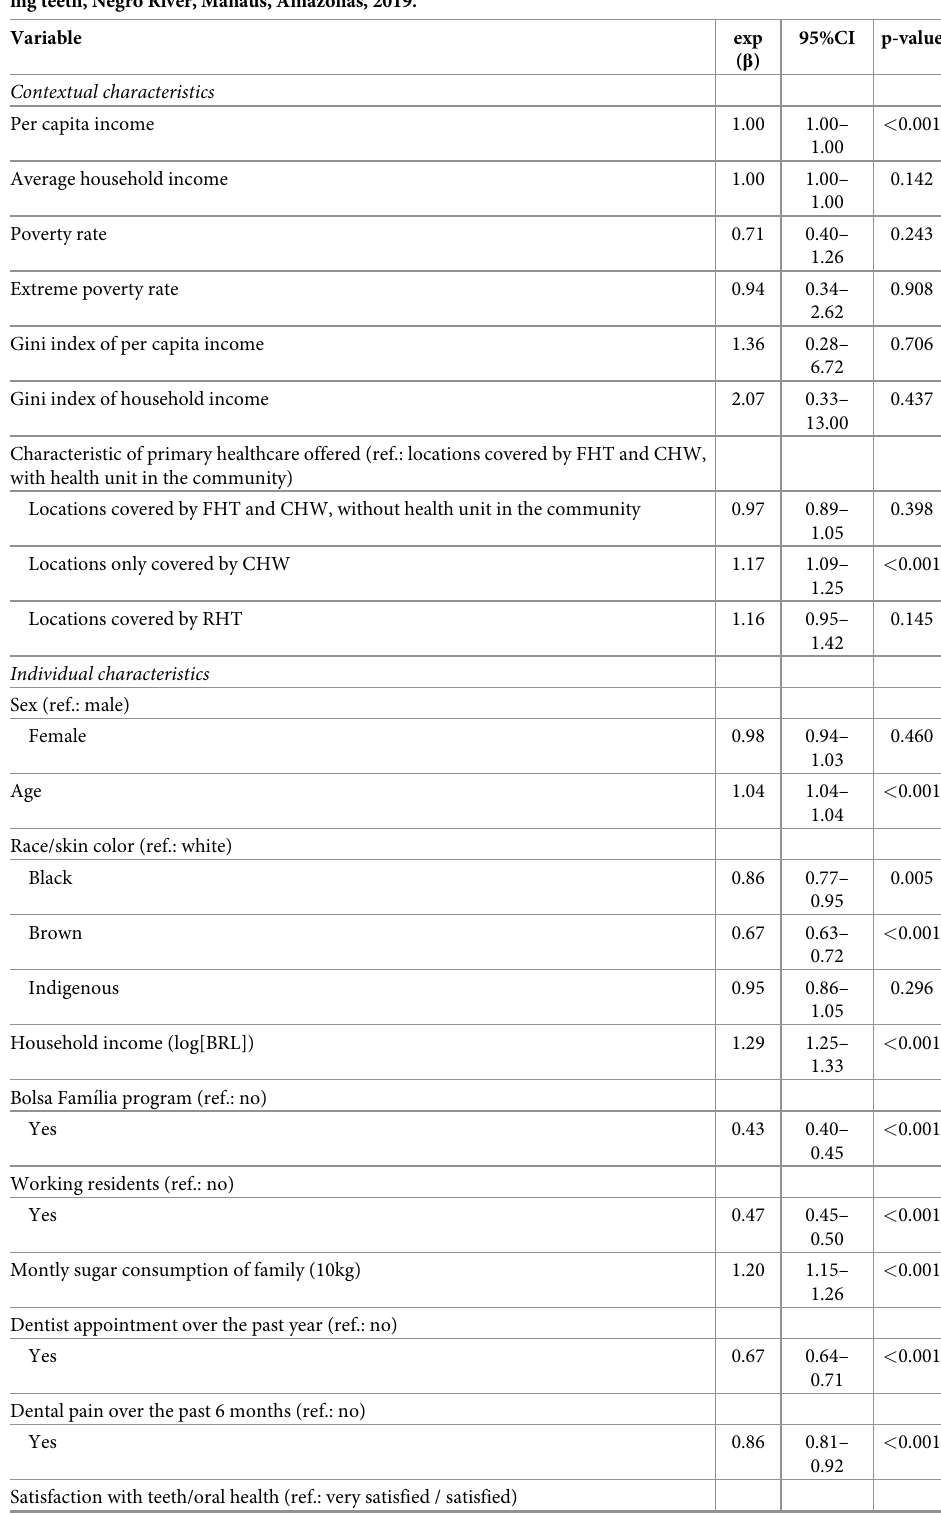
Table 2. Unadjusted rate ratios for the contextual and individual variables and the self-reported number of miss- ing teeth, Negro River, Manaus, Amazonas,